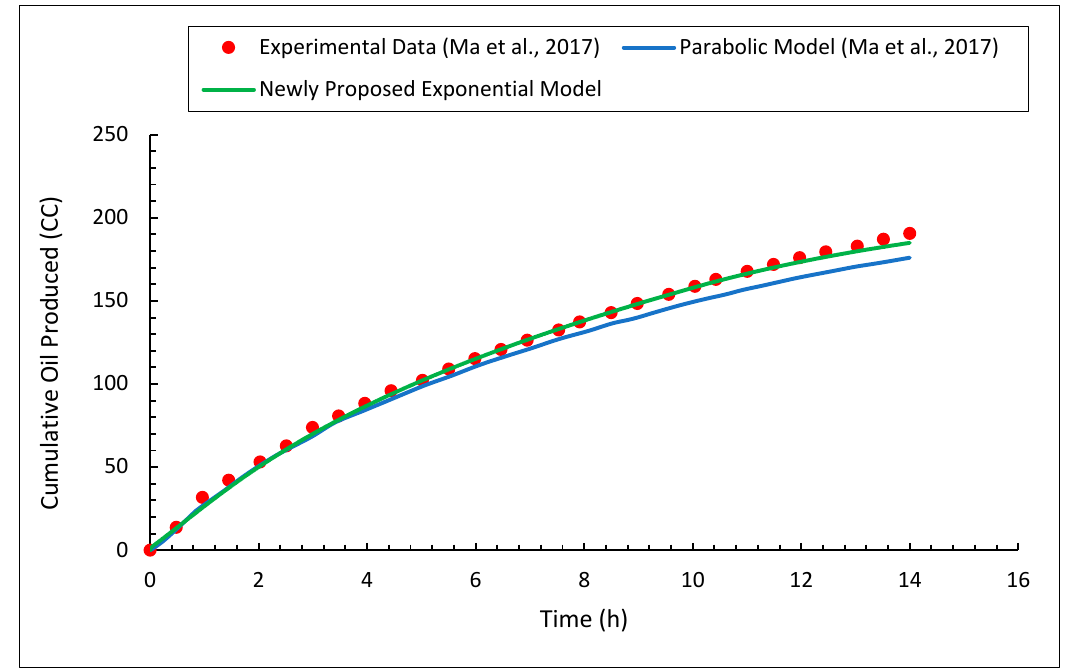
Figure 21. Comparison of the cumulative produced oil estimated by the newly proposed exponential model, experimentally measured cumulative produced oil [3], and cumulative produced oil estimated by the parabolic model proposed by Ma et al. [3] in test #1.